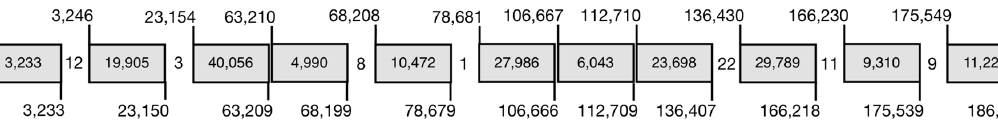
Figure 2. The grey boxes show the contig sizes of reassembled VARV-VD21-uvic. The top-left and bottom-right numbers indicate the start and stop positions of the contigs, respectively. Numbers between the grey boxes show the number of Ns needed to align the contigs with the VARV-Bang- 1975 reference genome. Some contigs abut but do not have reads to join them.